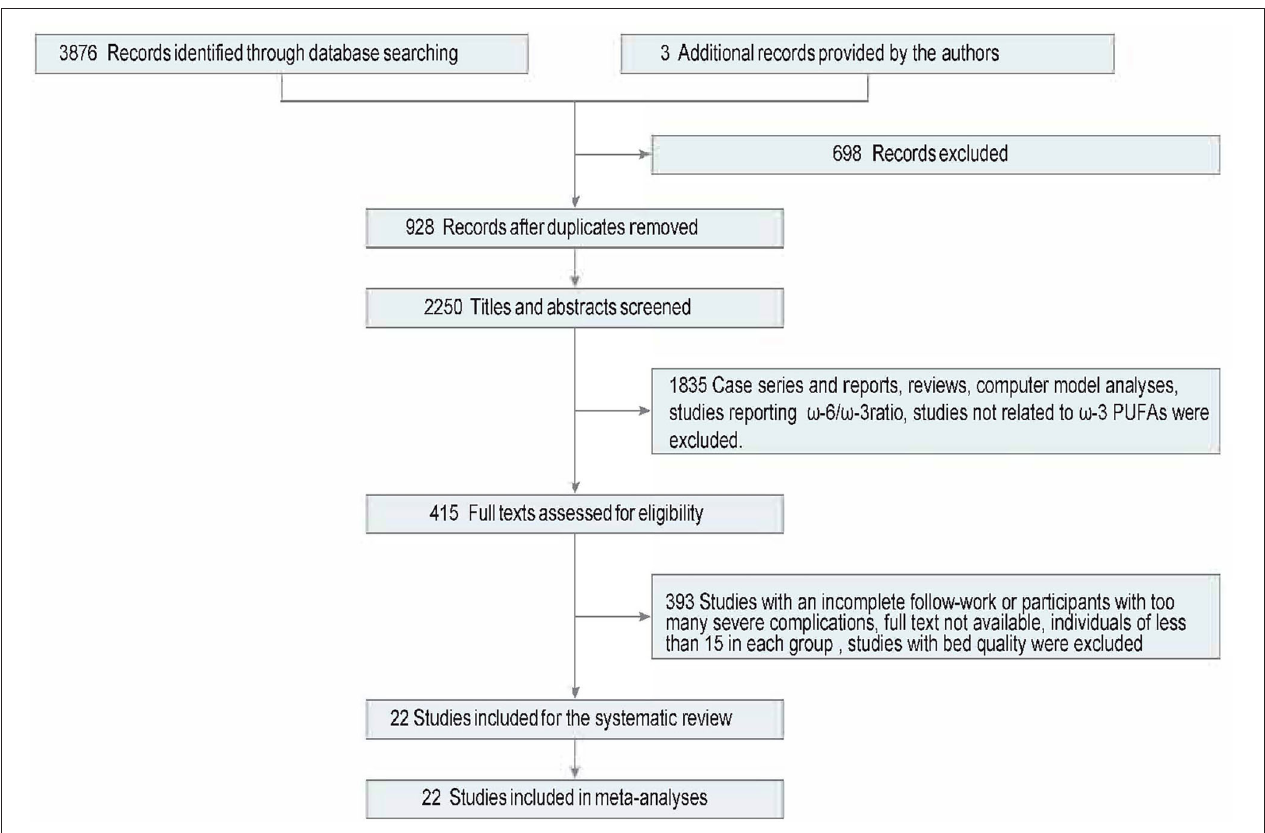
FIGURE 1 | Flowchart of literature